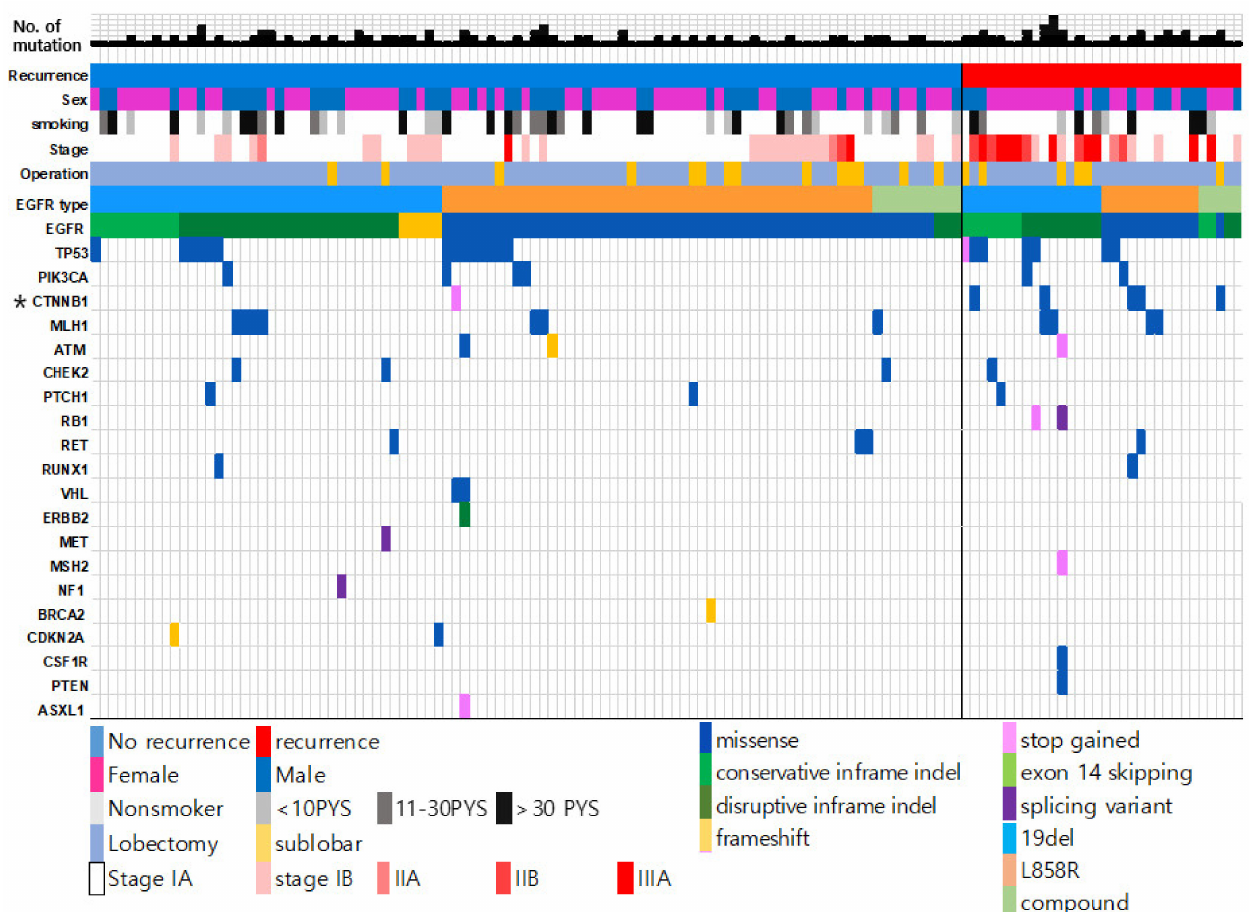
Figure 1. Genetic landscape of resected EGFR–mutated lung adenocarcinoma. The mutation data from all the patients in this study are included. The middle vertical line divides the patients into two groups: recurrence case ( right ) and non-recurrence case ( left ).